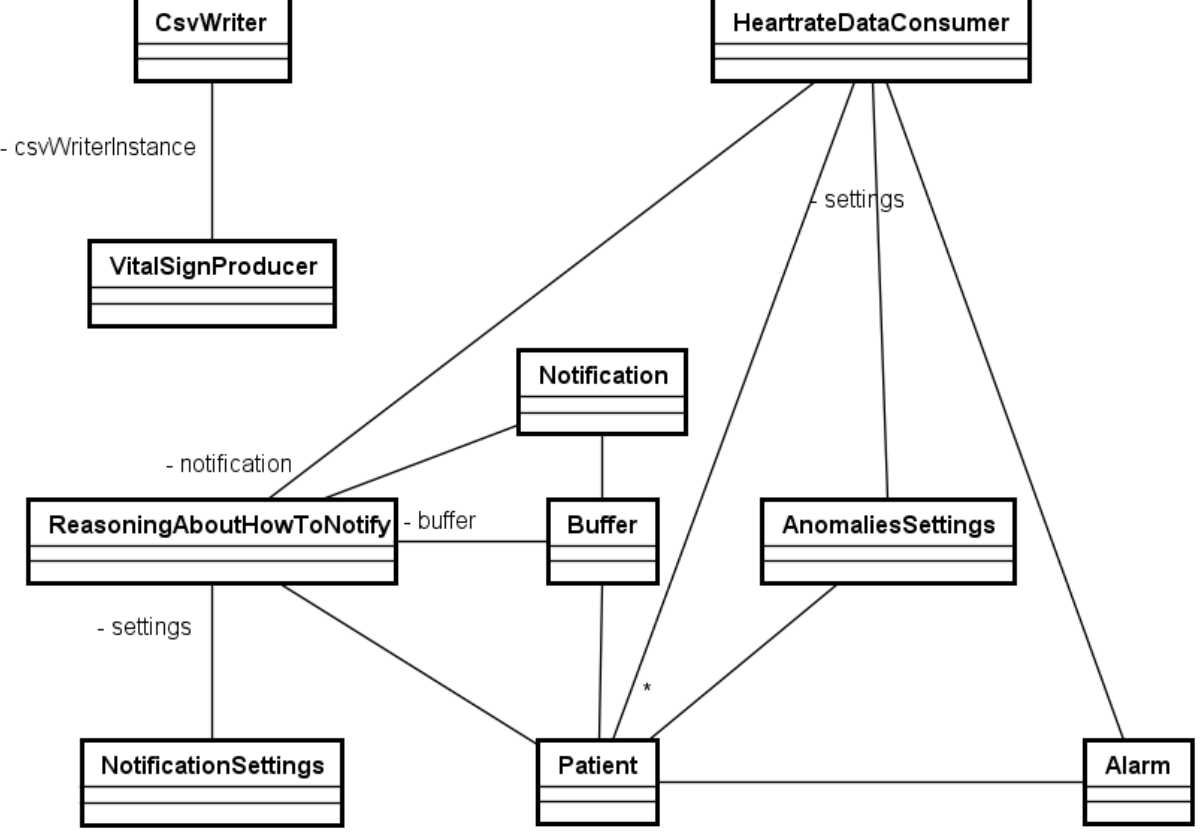
Figure 9. The class diagram for our application, where the consumer application monitors a specific vital sign based on the anomalies settings defined for each patient.